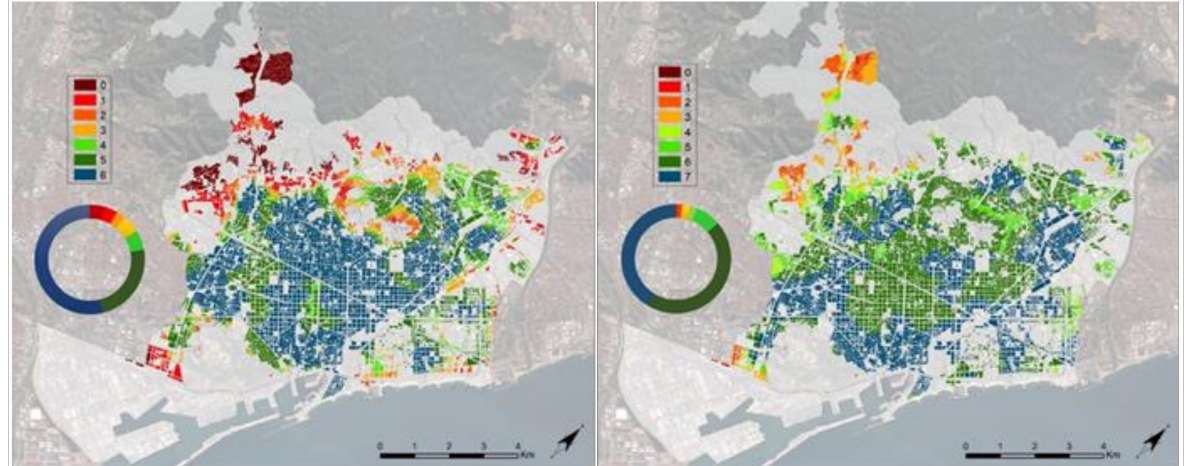
Figure 5. Provisioning functions ( left side ) and entertainment functions ( right side ). Number of variables accessible simultaneously from each of the parcels. Source: own elaboration based on data from Open Data BCN [42] and the Urban Map of Catalonia (MUC) [48] and the 1: 5000 Orthophoto from ICGC, used under a CC BY 4.0 license [41].